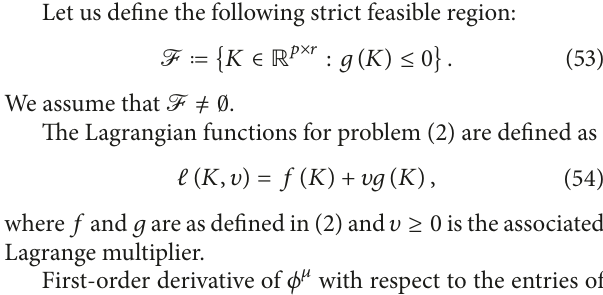
Algorithm 7 to compute an output feedback gain matrix 𝐾 ∗ ,